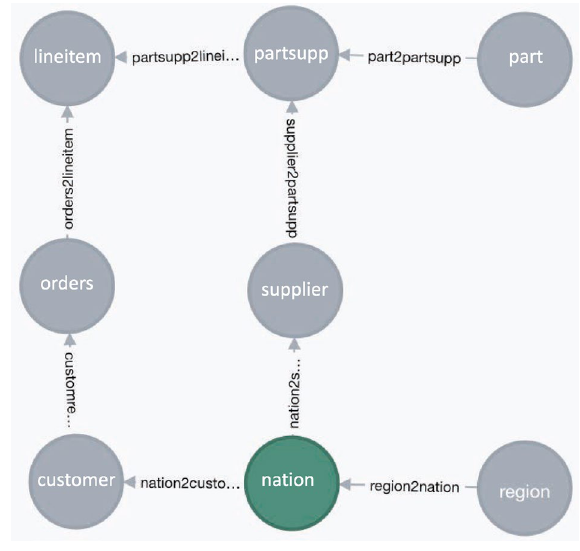
Fig. 1 The database schema for TPC-H benchmark